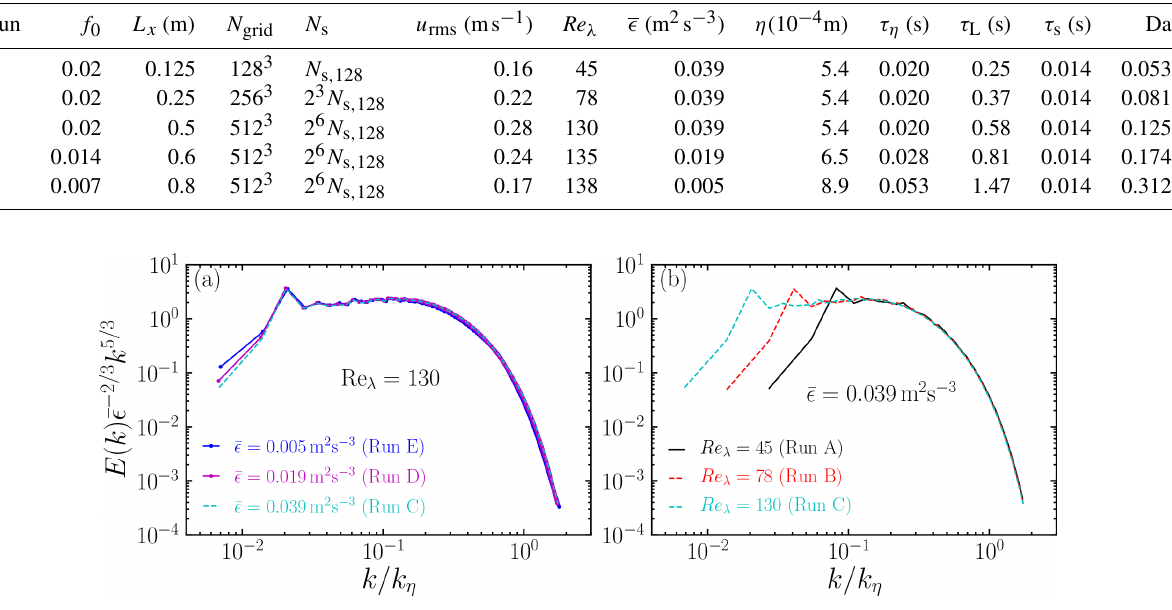
Table 2. Summary of the simulations; see text for explanation of symbols.